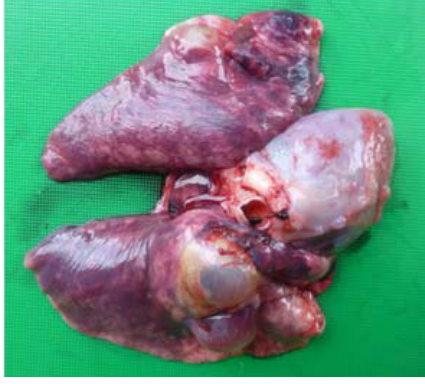
Figure 2. Lungs with hydatid cysts and heart. Photo: A. Shima.